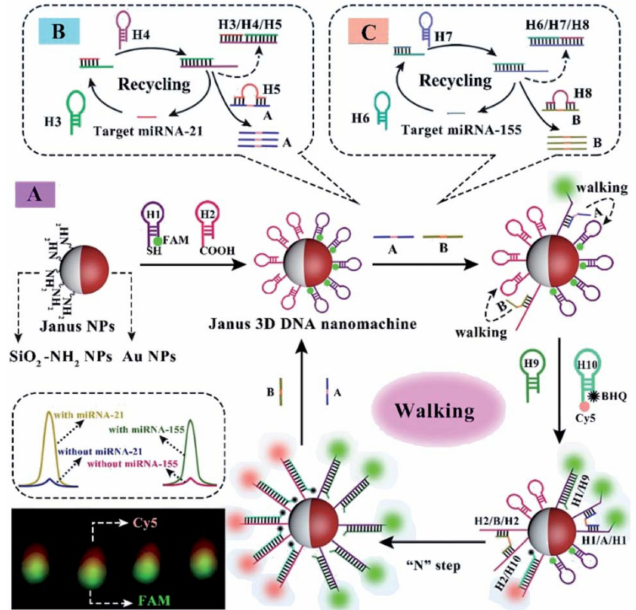
Figure 12. ( A ) Schematic illustration of the mechanical principle of the Janus 3D DNA nanomachine for simultaneous detection and sensitive fluorescence imaging of miRNA-21 and miRNA-( B , C ) double feet catalyst strands A and B obtained by the conversion of target miRNA-21 and miRNA-155 with the help of catalytic hairpin assembly (CHA) DNA amplification, respectively. Reprinted with permission from ref. [186]. Copyright The Royal Society of Chemistry